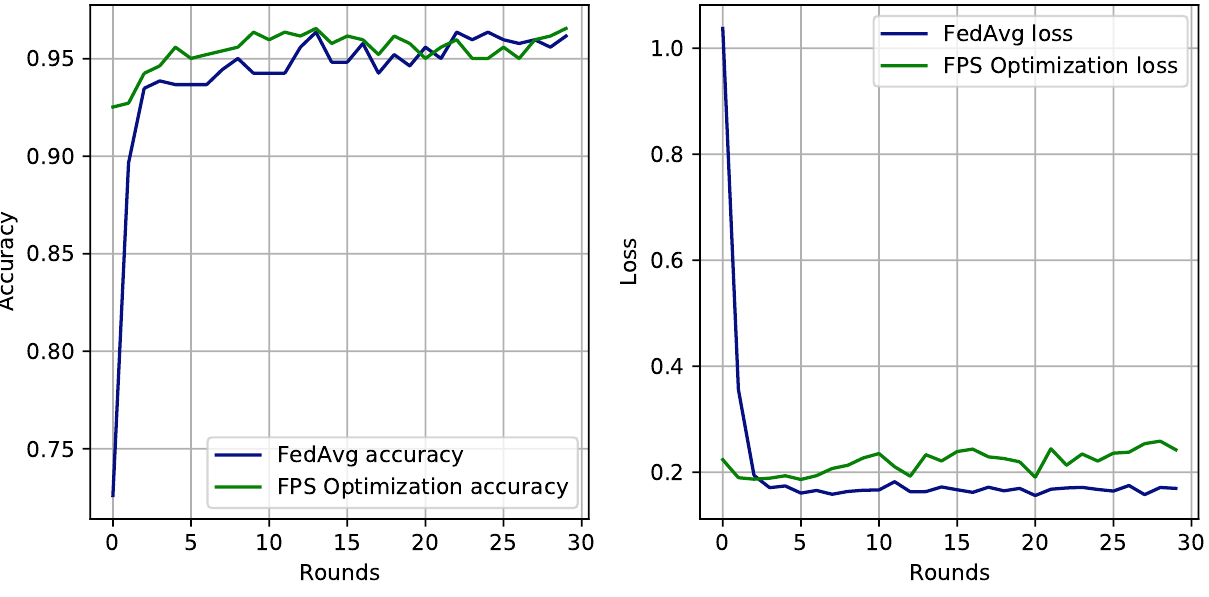
Figure 7. Comparison of the FPS Optimization and FedAvg Accuracy and Loss Results for the Chest X-ray (Pneumonia)